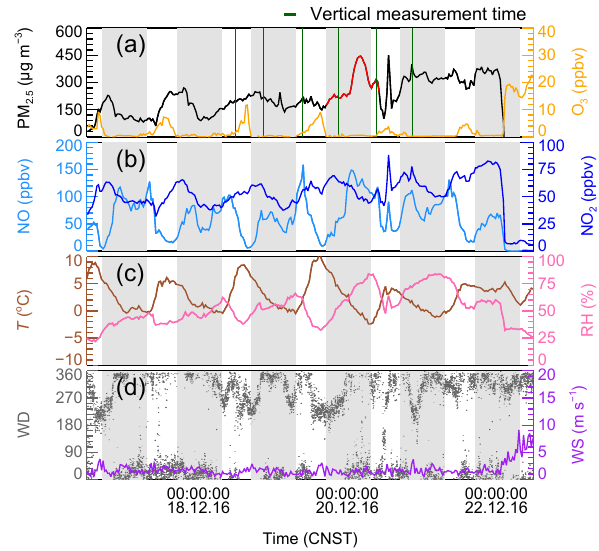
Figure 2. Time series of (a) PM 2 . 5 and O 3 , (b) NO and NO 2 , (c) temperature ( T ) and relative humidity (RH), and (d) wind di- rection (WD) and wind speed (WS) from 16 to 22 December 2016 at the PKU site in Beijing, China. The shaded region represents the nighttime periods. The red line in (a) shows an example of fast PM 2 . 5 enhancement on the night of 19 December and the green lines are the time periods when the vertical measurements were con- ducted at the IAP